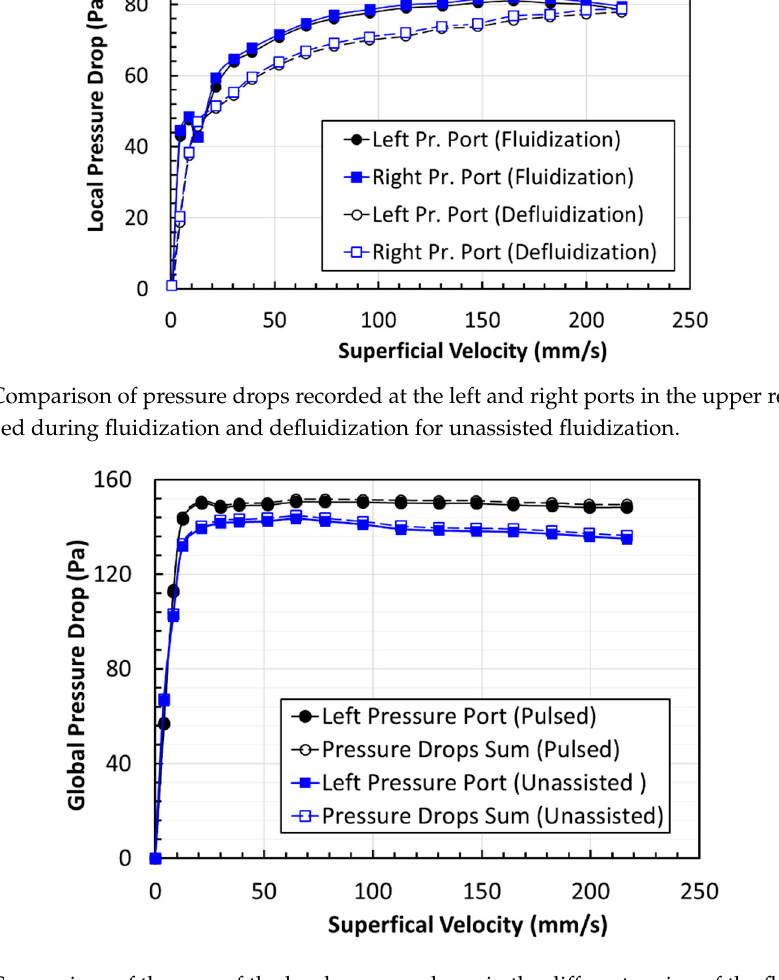
Figure 7. Comparison of the sum of the local pressure drops in the different region of the fluidized bed with the overall pressure drop for both unassisted and pulsed fluidization.